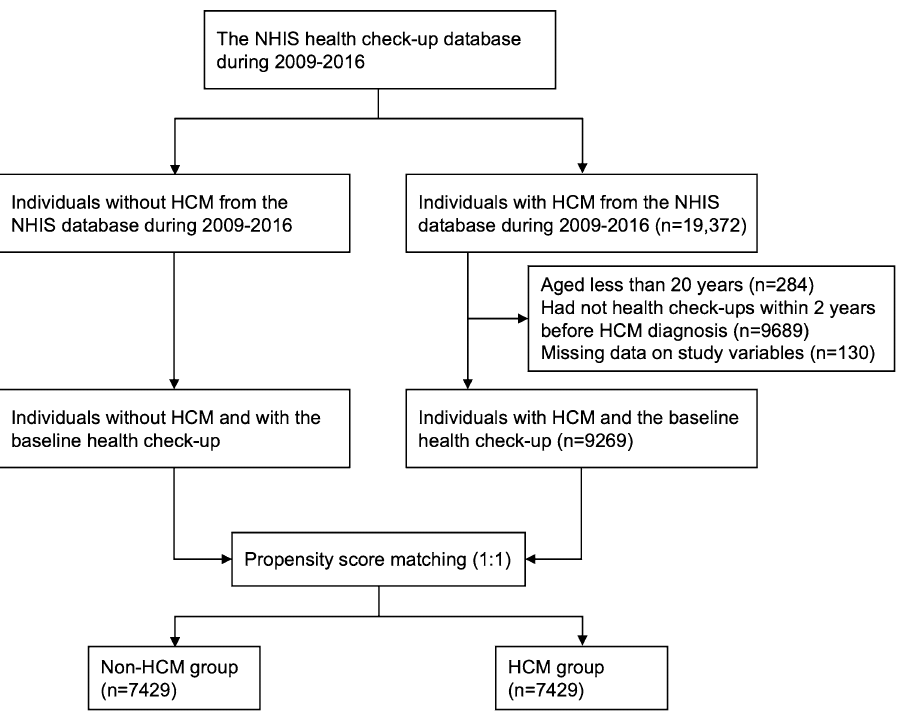
Figure 1. The flowchart of the study design. Using the NHIS database, subjects who were diagnosed with HCM between 2009 and 2016 were selected and exactly matched at a 1:1 ratio with the non-HCM group using a propensity score. HCM hypertrophic cardiomyopathy, NHIS National Health Insurance